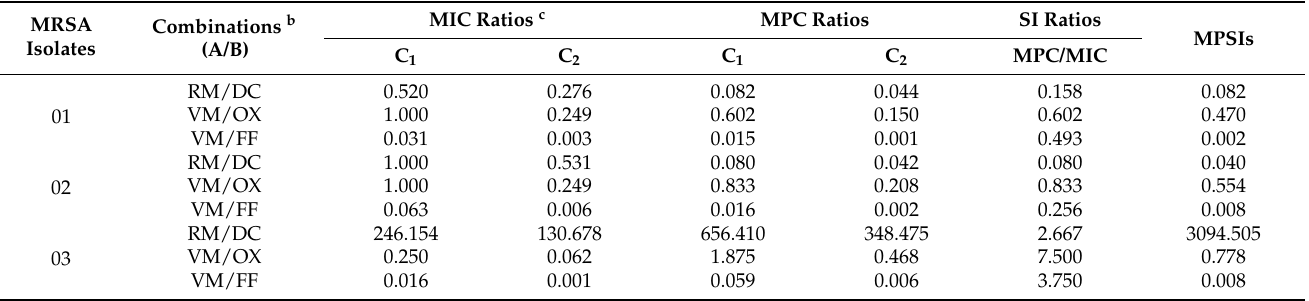
Table 3. The ratios for the MIC, MPC or SI alone of two antimicrobial agents in three drug combina- tions against three MRSA isolates, and the MPSIs of these combinations a